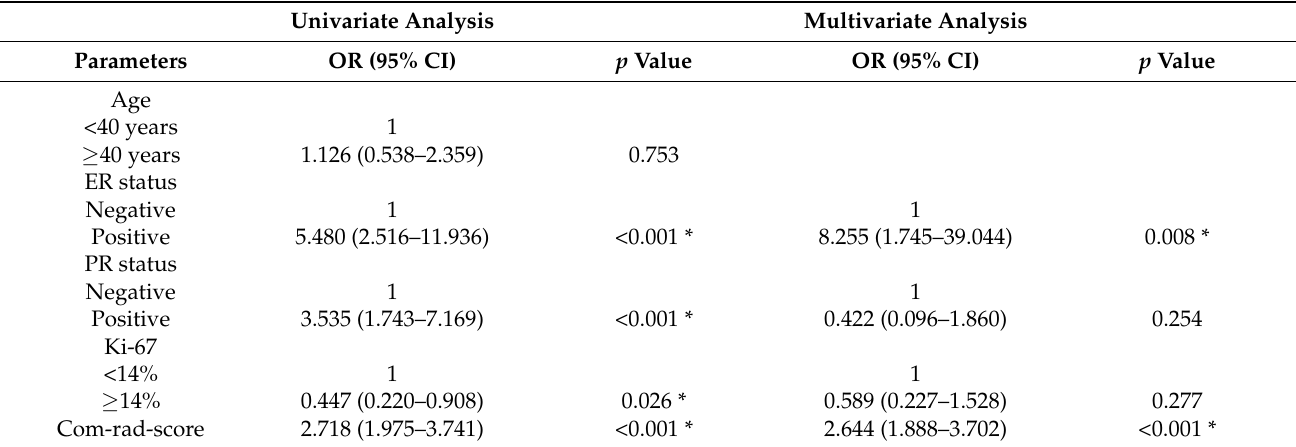
Table 5. Univariate and multivariate logistic regression analyses of the clinical parameters and com-rad-score for HER-2 2+ status in the training cohort.